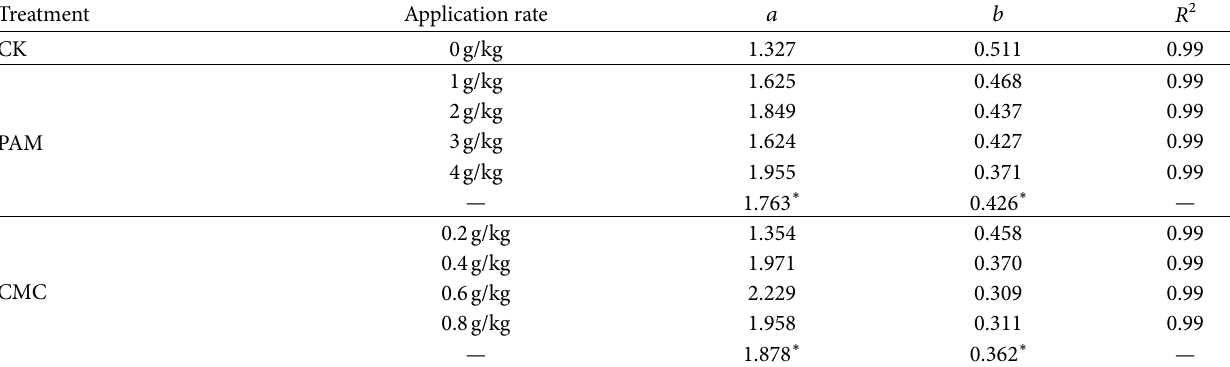
Table 2: Influence of PAM and CMC application rates on soil